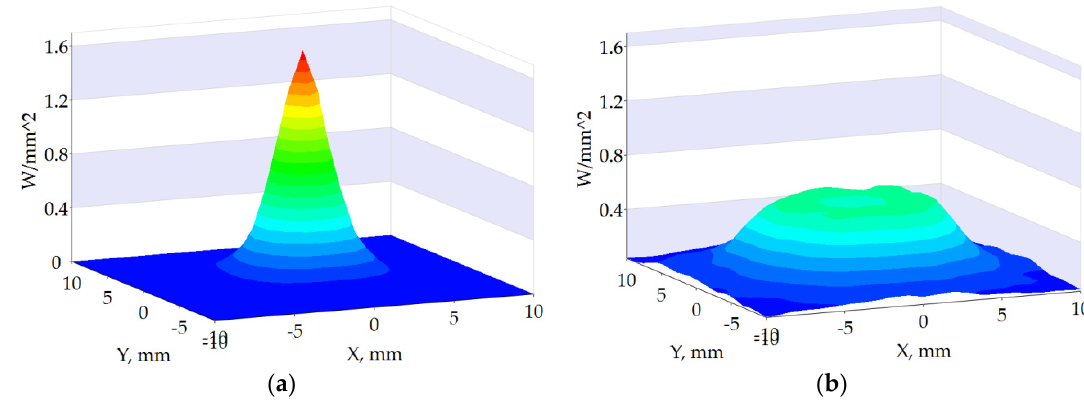
Figure 7. Irradiance distribution on the solar cell: ( a ) the conventional CPV unit; and ( b ) the proposed CPV unit.